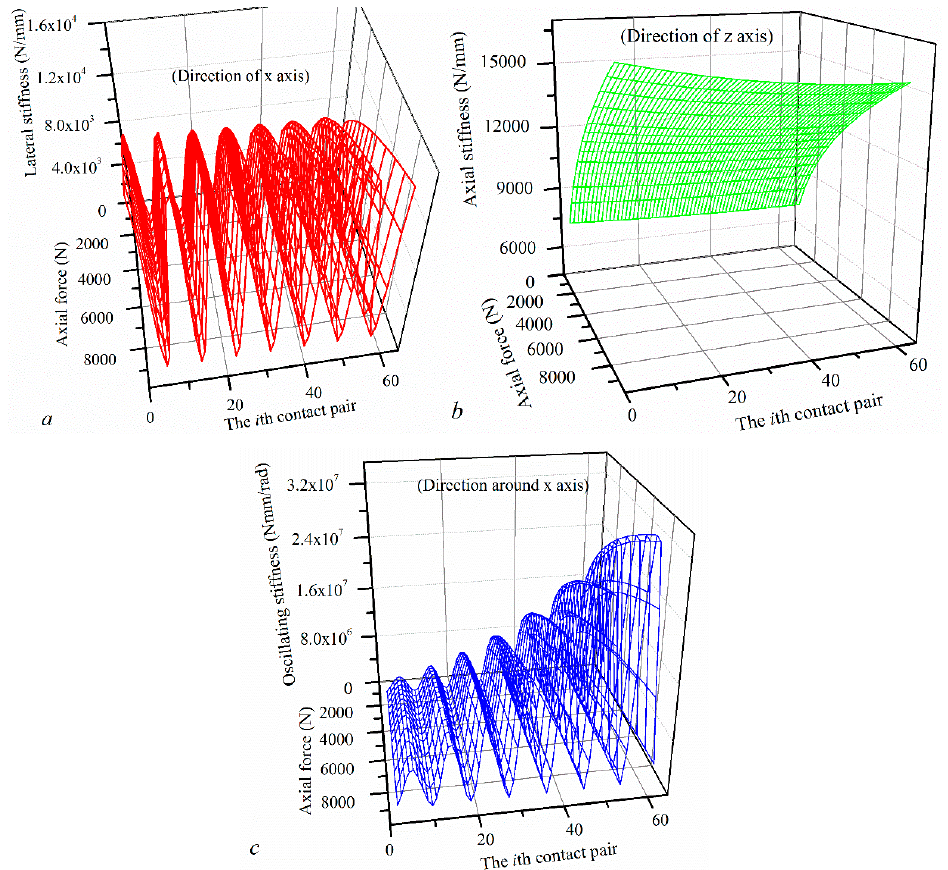
Figure 19. Variation of the local stiffness with the contact position and the axial force. ( a ) Local lateral stiffness of the x axis. ( b ) Local axial stiffness of the z axis. ( c ) Local oscillating stiffness around the x axis.